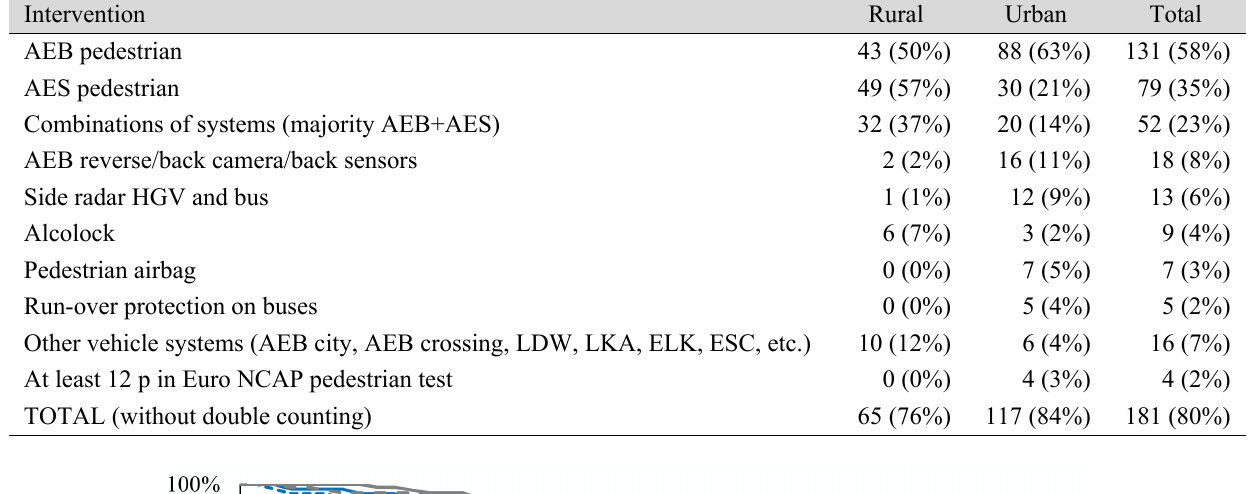
Table 3 Potentials of vehicle interventions to prevent pedestrian fatalities Intervention